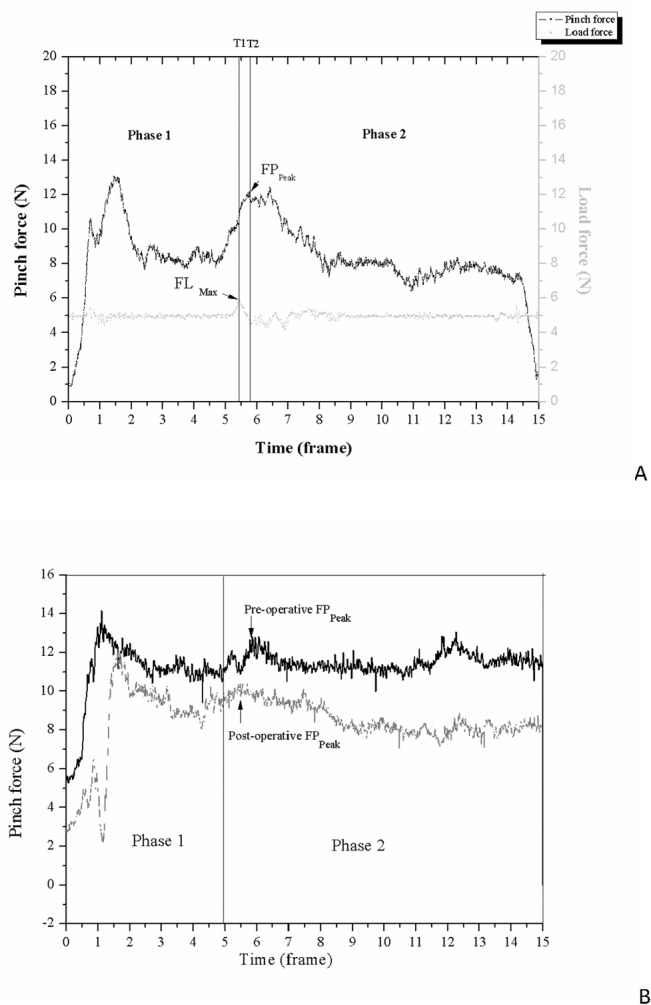
Pinch force and load force in the force–time relationship figure.(A) The peak pinch force (FPPeak) and the maximum load force (FLMax) are shown. (B) The pinch force with time series detected at the pre- and post-operative assessments of subject 6.